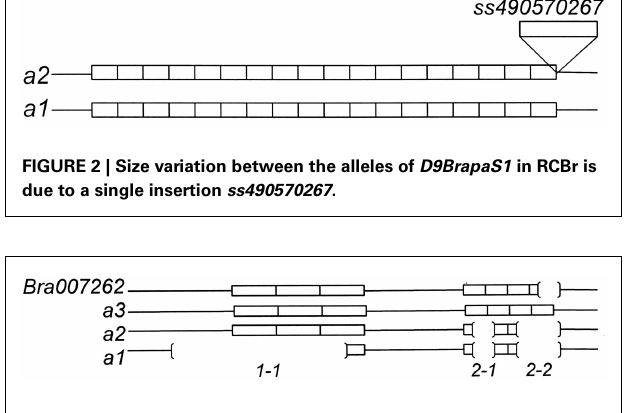
FIGURE 3 | Size variation between the alleles of D9BrapaS4 in RCBr is due to a multiple indels designated by 1-1 ( ss490570298) , 2-1 ( ss490570286) , and 2-1 ( ss490570293)